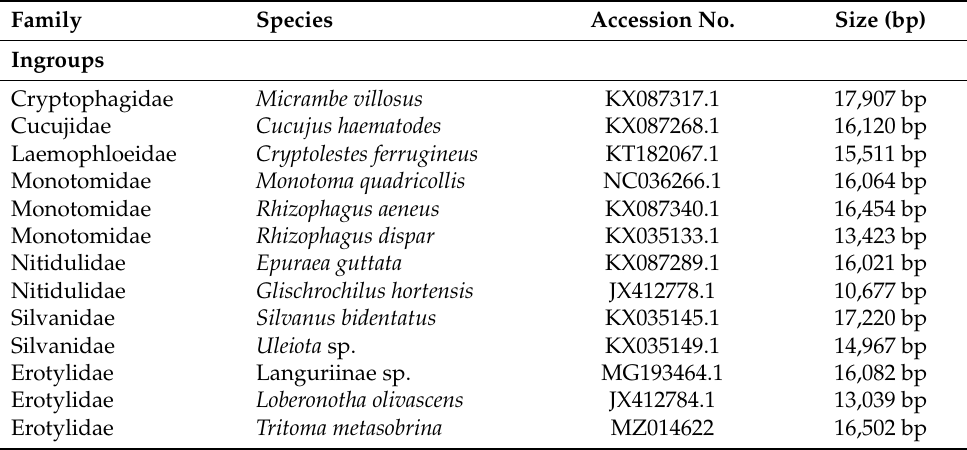
Table 1. List of taxonomic groups used for the phylogenetic analyses in this